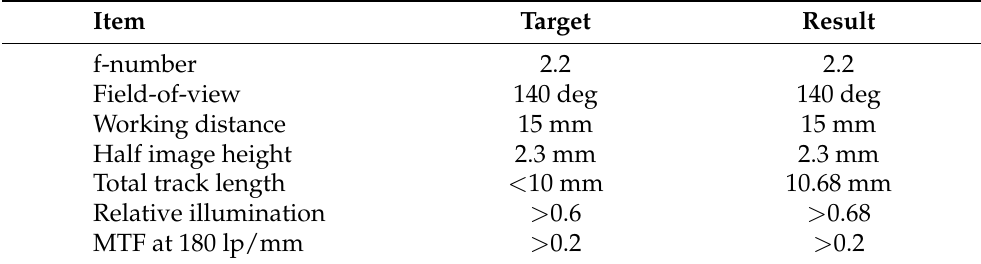
Table 3. Specifications of the optimized system.